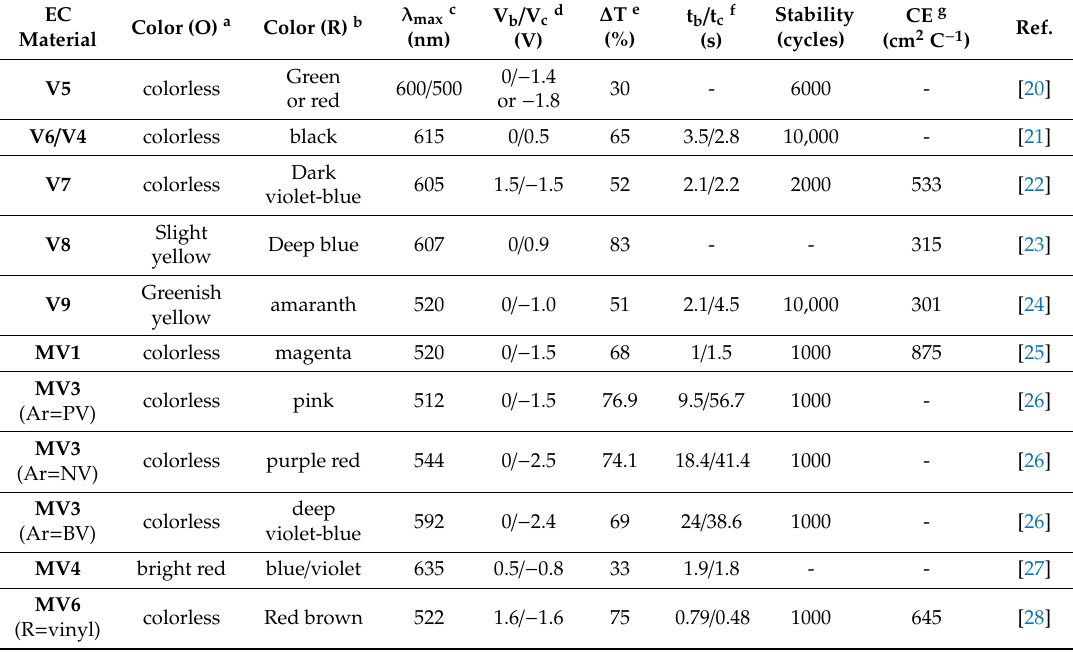
Table 1. ECD performance of selected small viologen molecules and their